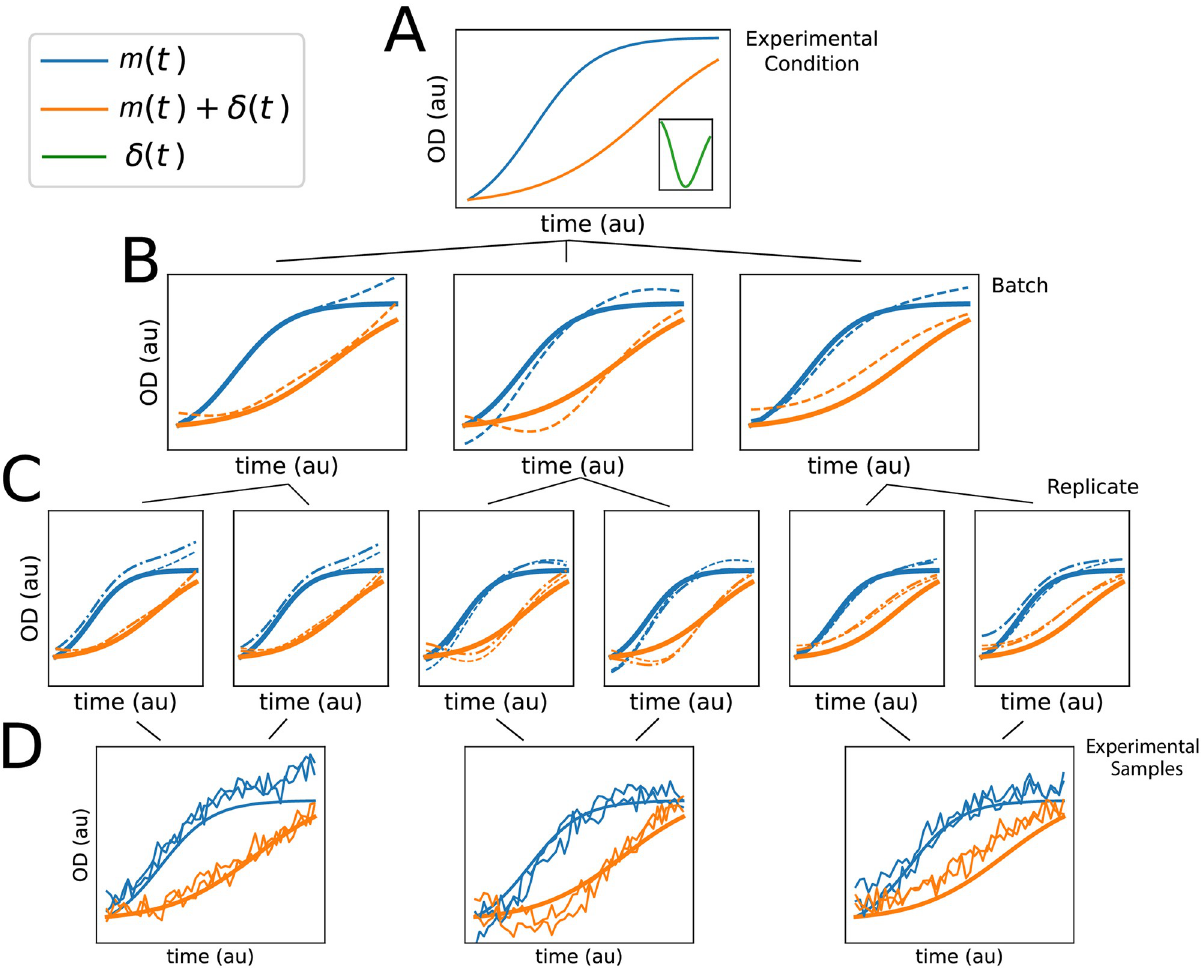
Fig 3. Hierarchical model of functional data. Representative diagram of hierarchical variation present in microbial growth data. Each tier of graphs represents a different variation source, and lines indicate relationship between them: experimental condition is the true growth behavior of interest, with the condition repeated across batches, and replicates repeated within each batch. (A) Functional phenotypes m ( t ) (blue), m ( t ) + δ ( t ) (orange), and δ ( t ) (green curve in inset). (B) Batch effects on m ( t ) and m ( t ) + δ ( t ). Each plot is a different batch, solid lines are the true functions as in (A), and the dashed lines are the observed batch effect of m ( t ) and m ( t ) + δ ( t ) for the corresponding batch. (C) Replicate effect within batches. Each axis is a different replicate, solid and dashed lines as in (B), dotted-dashed line is the observed replicate function. (D) Observations from the model described in (A-C). Each curve is sampled with a mean drawn from the global mean, with added batch and replicate effects (dotted-dashed lines in C) and iid observation noise. Each axis is a different batch. The smooth solid lines are the true functions m ( t ) and m ( t ) + δ ( t ) in (A).